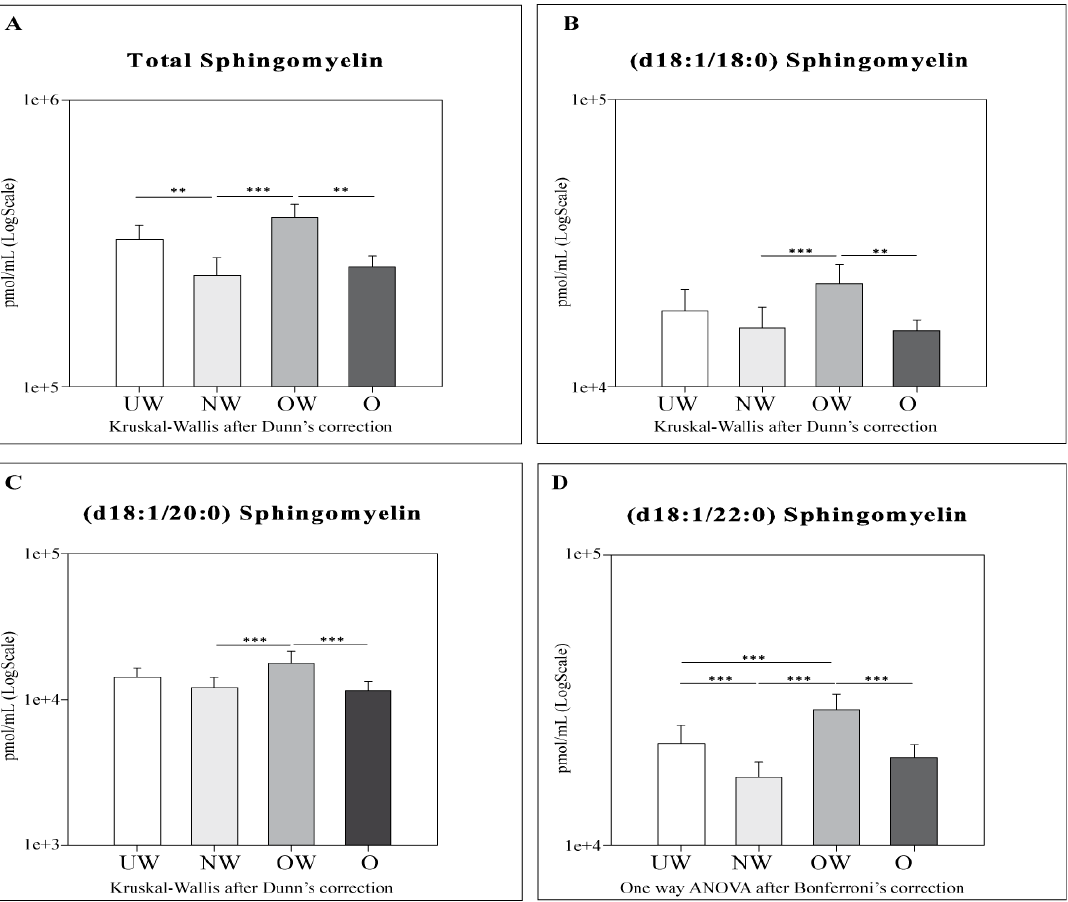
Figure 3. LC-MS results for total sphingomyelins ( A ), SMs (d18:1 / 18:0) ( B ), Cer (d18:1 / 20:0) ( C ), and Cer (d18:1 / 22:0) ( D ). Data are expressed as pmol / mL in Log scale; p values are expressed as ** p -value < 0.01, and *** p -value < 0.001.